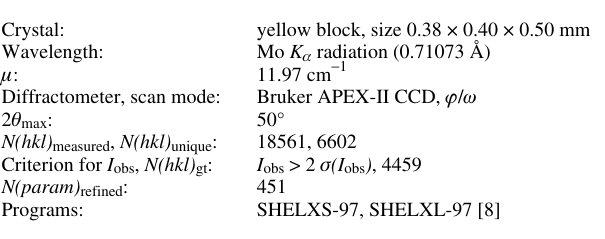
Table 1. Data collection and